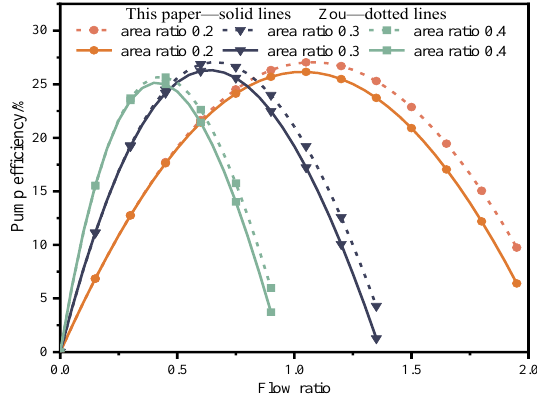
Figure 3. Verification of the basic characteristic equation.